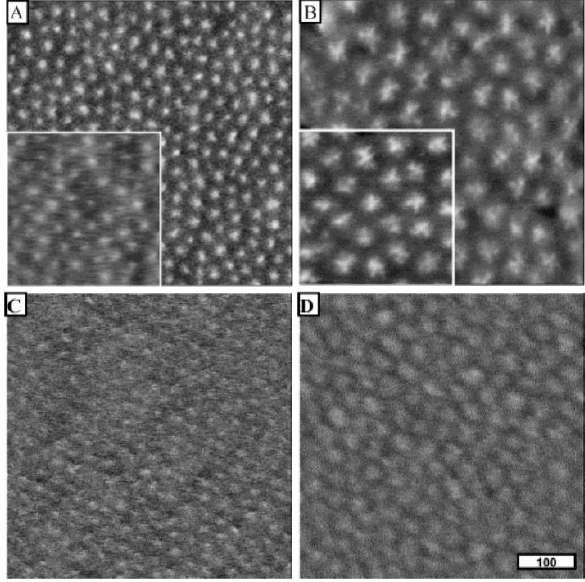
Figure 6. AFM phase contrast images for films of arborescent polystyrene- graft -polyisoprene obtained by spin-casting (concentration ~1 mg/mL): G0PS-PIP30 in heptane (A) and chloroform (C) ; G1PS-PIP30 in heptane (B) and chloroform (D) . The insets of (A) and (B) are the height images, showing the topology of the monolayers, and the 100-nm scale bar shown in (D) is the same for all the images. Reprinted from Reference 30 by permission from the American Chemical